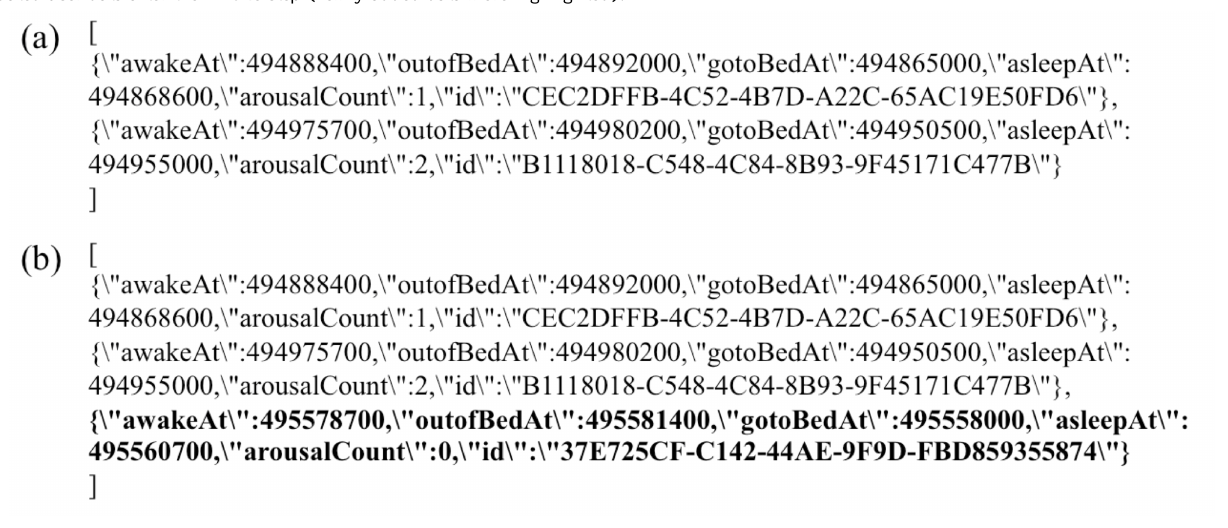
Figure 3. The user data (excerpt) queried from the state in the normal mobile health data update. (a) The initial user data after the Deploy step. (b) The updated user data after the Invoke step (newly added data were